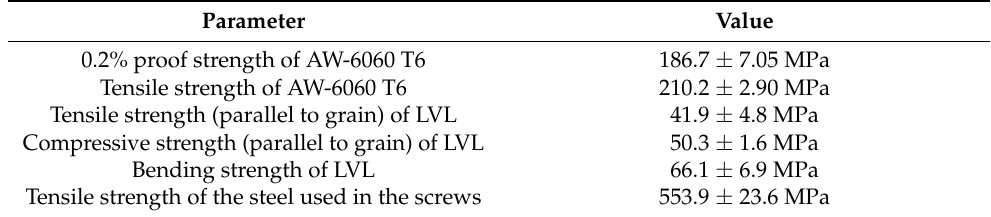
Table 1. The parameters of the materials used in the composite beams, determined in the previous laboratory tests